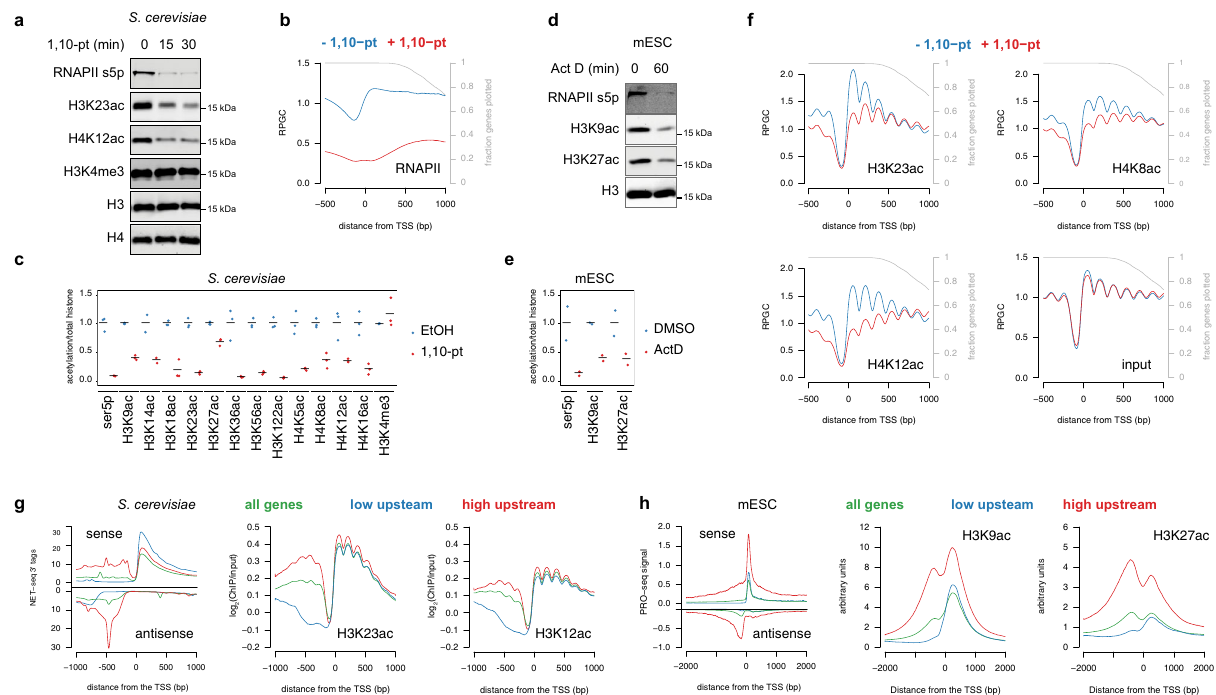
Fig. 1 The majority of histone acetylation is dependent on transcription. a Whole-cell extracts from S. cerevisiae cells before and after treatment with 1,10- pt were subjected to immunoblot analysis with the indicated antibodies. Experiments were performed in triplicate with quanti fi ed results shown in ( c ). Raw immunoblot data is provided in the Source Data fi le. b Average pro fi le of RNAPII (Rpb3 ChIP-seq 73 ) at 5206 transcribed genes aligned by the TSS before (blue) and after a 15 m treatment with 1,10-pt (red). Only data until the polyadenylation site (PAS) was included, and the gray line represents the fraction of genes still being plotted. RPGC reads per genomic coverage, TSS transcription start site. c Strip plots of histone PTM immunoblot signals normalized to histone H4 levels from three independent yeast whole-cell extracts from cultures without (blue) and with (red) a 15-min treatment with 1,10-pt. Horizontal lines indicate the mean, with the vehicle control set to 1. d Nuclear extracts from mouse ESCs before and after treatment with actinomycin D were subjected to immunoblot analysis with the indicated antibodies. Experiments were performed in duplicate with quanti fi ed results shown in ( e ). Raw immunoblot data is provided in the Source Data fi le. e Strip plots of histone acetylation immunoblot signals normalized to histone H3 from two mESC nuclear extracts from independent cultures without (blue) and with (red) actinomycin D. Horizontal lines indicate the mean, with the vehicle control set to 1. f Average pro fi le of H3K23ac, H4K8ac, and H4K12ac (MNase ChIP-seq) and input at 5206 genes aligned by the TSS before (blue) and after (red) a 15- min treatment with 1,10-pt. Data from 1,10-pt-treated cells was normalized to untreated (see “ Methods ” ). g The average signal relative to the TSS for S. cerevisiae NET-seq 41 , H3K23ac 33 , and H4K12ac ChIP-seq data relative to all genes (green) or 832 transcribed genes that have low (blue) or high (red) upstream NET-seq signal. The ChIP data is presented as log 2 (ChIP/input) as nucleosome density is not consistent between the different gene bins. h The average signal relative to the TSS for PRO-seq 74 , and H3K9ac and H3K27ac ChIP-seq data relative to all genes (green) or 3035 transcribed genes that have low (blue) or high (red) upstream PRO-seq